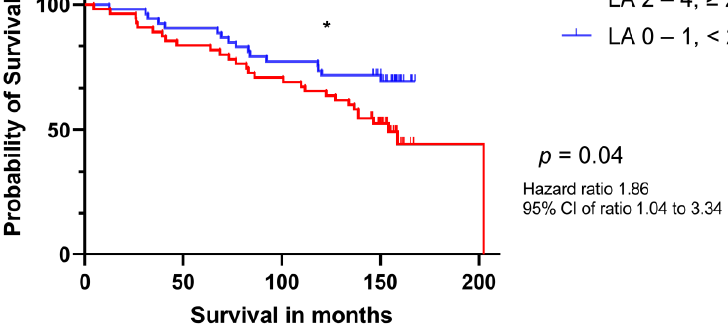
Figure 3. Kaplan-Meier estimates of survival in patients with breast cancer according to HCMV LA status. ( a ) estimated survival of 82 patients whose tumors were LA positive (red) and of 26 patients whose tumors were LA negative (blue). ( b ) estimated survival of 55 patients whose tumors showed ≥ 25% of LA positive cells and of 53 patients whose tumors showed less than 25% positive cells or were negative (blue). Significance is indicated as following: * ( p < 0.05).